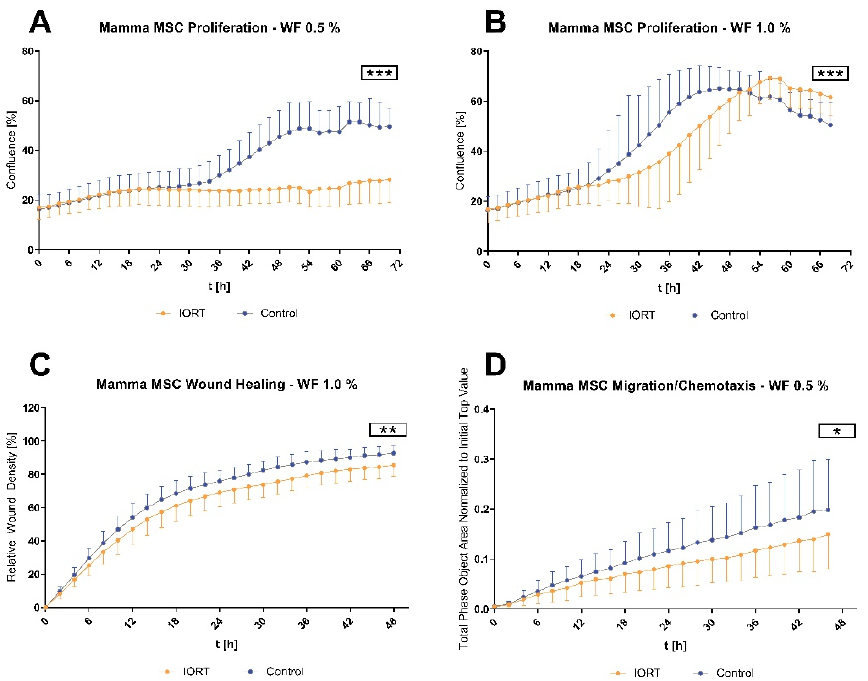
Figure 5. Functional analysis of MSC incubated with 0.5%/1% pooled WF concerning proliferation with 0.5 % WF ( A ), proliferation with 1.0 % WF ( B ), wound healing in 1.0 % WF ( C ) and chemotactic migration in 0.5 % WF ( D ). All assays were reproduced in 3 independent experiments with each 8–12 technical replicates for each condition. Indicated values: mean ± standard deviation in percent over time. Statistical analysis by MANOVA, * p < 0.05, ** p < 0.01, *** p < 0.0001.